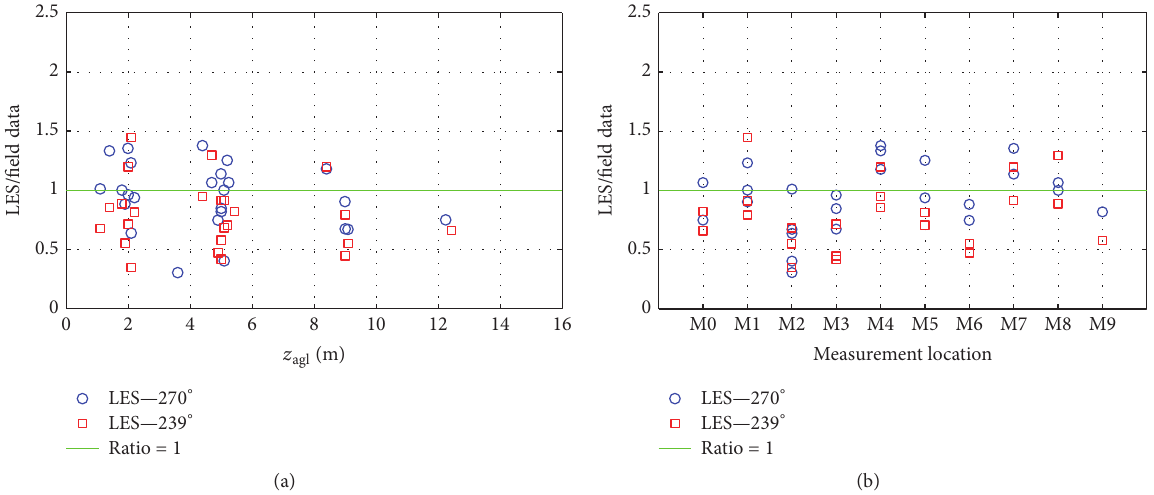
Figure 8: Ratio of LES to field data for the normalized TKE 𝑘/𝑢 2 ∗0 . The results from both wind directions are sorted with respect to the height above the ground level 𝑧 (a) and the mast measurement locations (b). agl